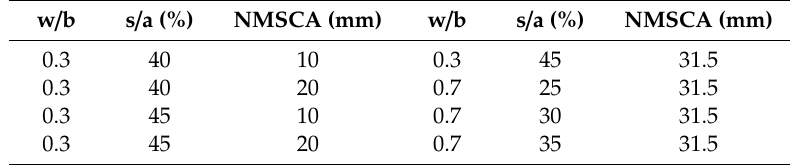
Table 2. Eight extreme mix proportions excluded from